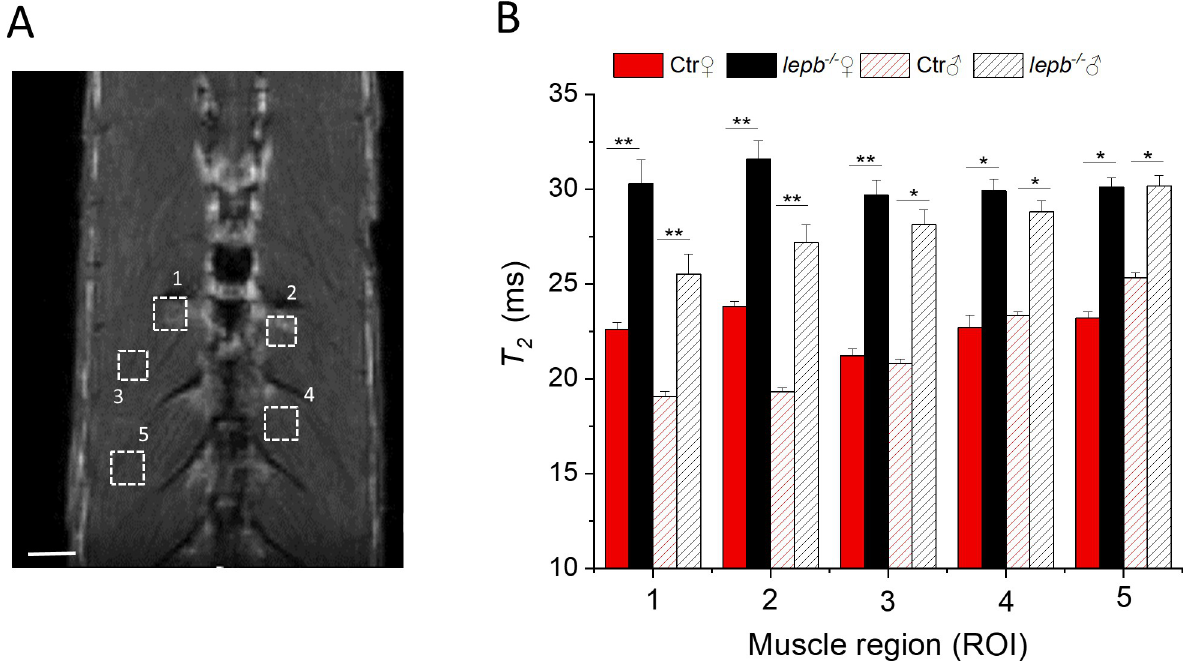
Fig 3. T 2 relaxation time measurements in various muscle regions of control (Ctr) and lepb -deficient ( lepb -/- ) adult zebrafish. (A) Anatomical T 2 –weighted MR coronal slices of an adult zebrafish, showing various muscle regions for T 2 measurements. Scale bar, 500 μ m. (B) T 2 relaxation time values were measured in five different muscle regions of female ( ♀ ) and male ( ♂ ) control (Ctr) and leptin-deficient ( lepb -/- ) zebrafish. The reliability test of T measurements was performed by Bonferroni test using a 1-way analysis of variance (ANOVA) to accomplish pairwise comparisons of the 2 data. At the 0.05 level, the T 2 population means of lepb -/- and Ctr are significantly different for both male and female zebrafish. Data represent the in ms ± standard deviation (SD) (Error bars) (95% C.I.); n = 6 per group; * p < 0.05, ** p < mean T 2